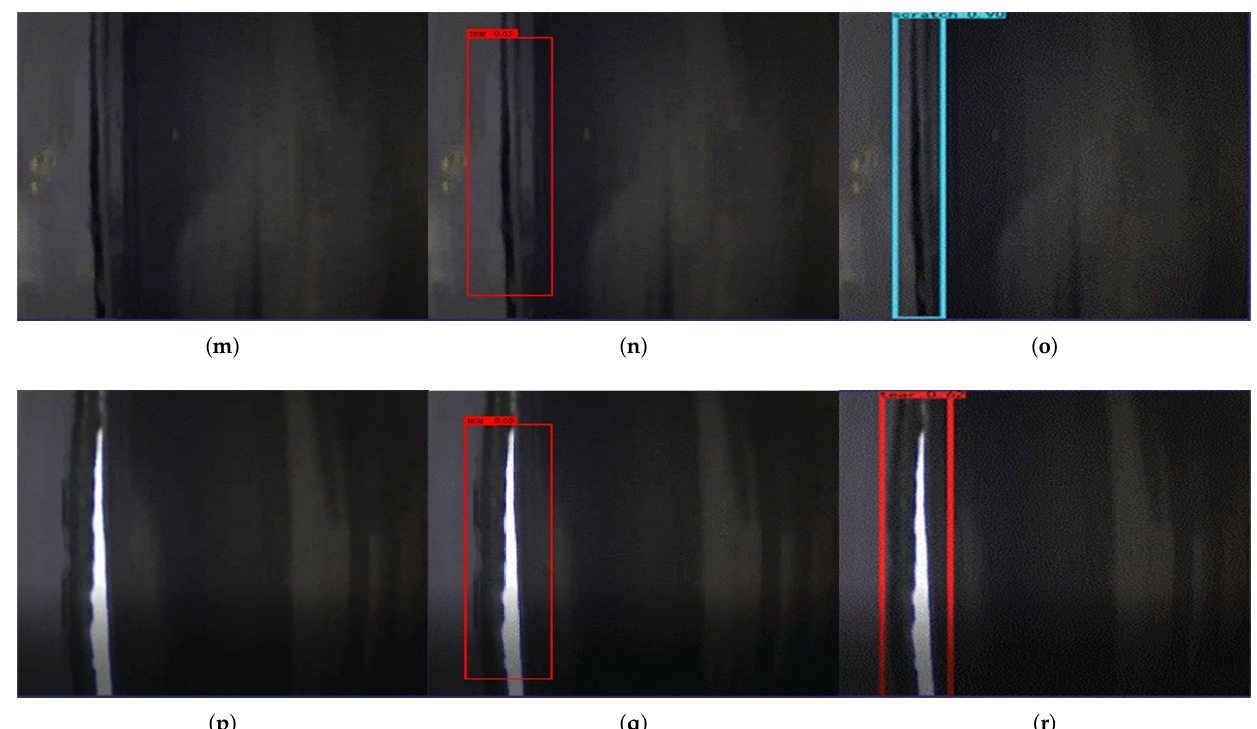
Figure 8. Generalization proficiency verification: ( a , d , g , j , m , p ) are the original images, ( b , e , h , k , n , q ) belong to the detection results using method in this paper, ( c , f , i , l , o , r ) are the detection results given in Refs.